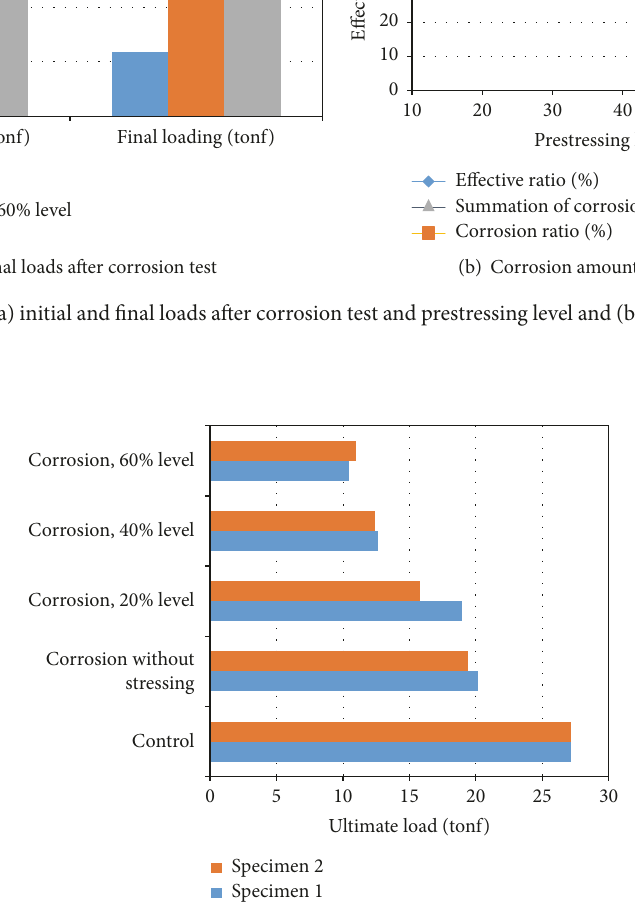
Figure 7: The relationship between ultimate loads and corrosion at different stress